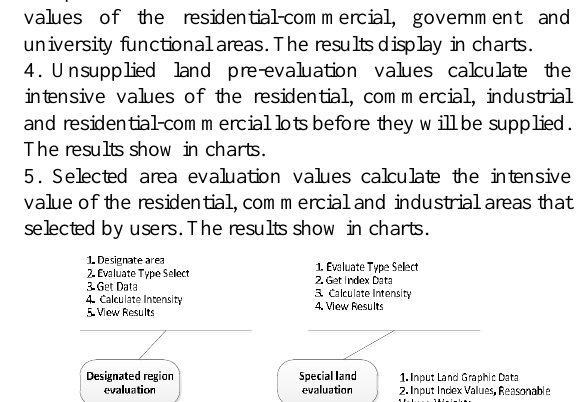
Figure 4. Metadata, XML data monitoring extraction method